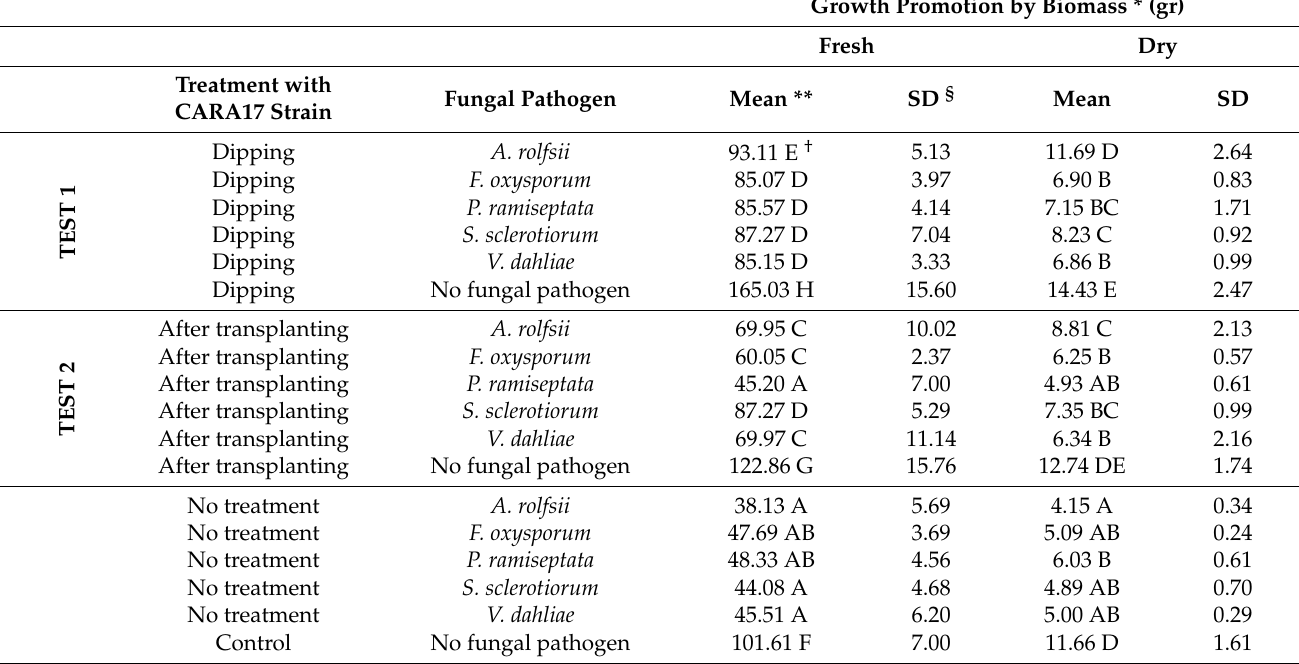
Table 3. Effectiveness of CARA17 strain on promotion of plant growth by biomass production of fennel seedlings.